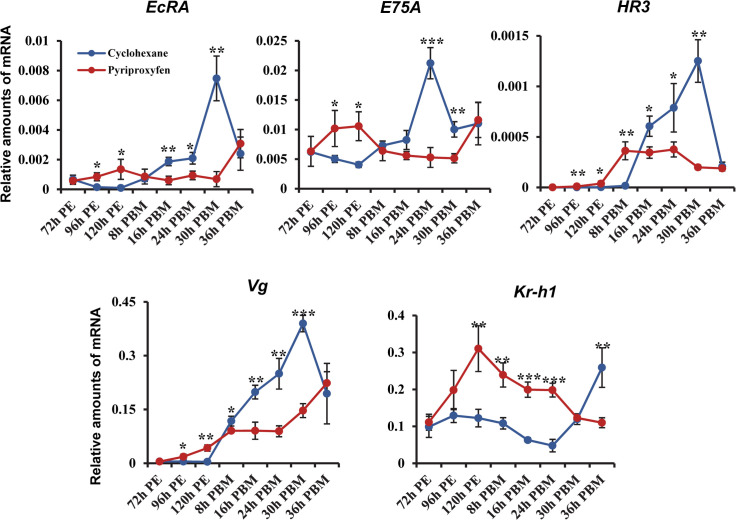
Expression patterns of selected hormone-regulated genes in PPF-treated mosquitoes.The mRNA levels were analyzed in the fat body of female mosquitoes at the indicated time points after PPF exposure at 72 h PE. The cyclohexane-treated mosquitoes were used as a control group. Transcript abundance was normalized to that of the Ribosomal Protein S7 (RpS7) gene. Data are shown as the mean ± standard deviation of three biological replicates. Statistical analysis was performed using a Student’s t-test (ns, p > 0.05; *, p < 0.05; **, p < 0.01; ***, p < 0.001).